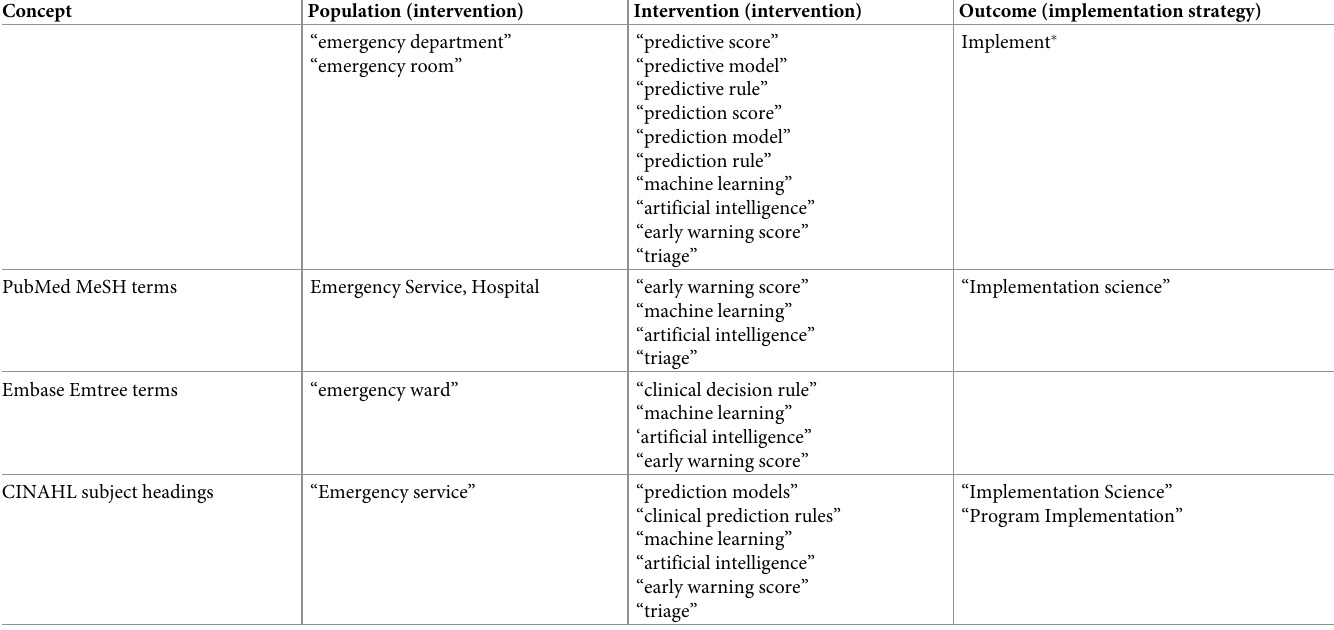
Table 2. Literature search